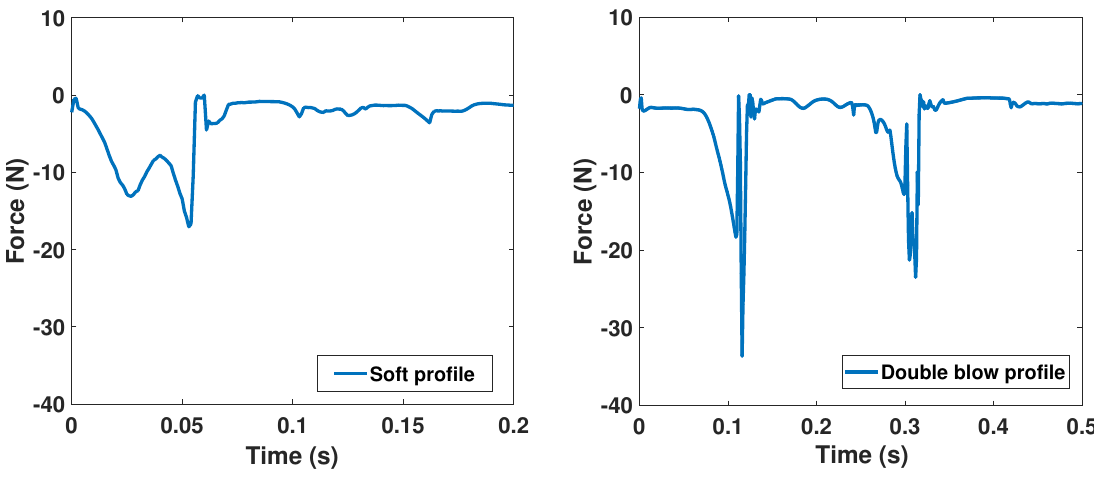
Figure 10. Force profiles F mod considered for the